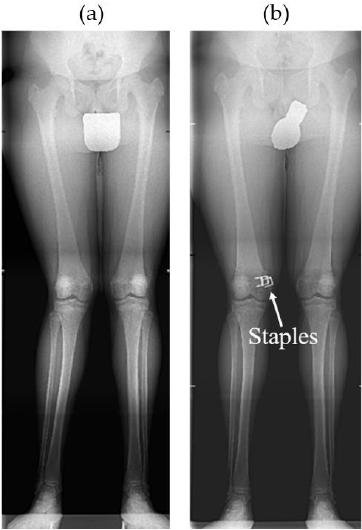
Figure 2. (a) Long radiogram of preoperative genu valgum and ( b ) consecutive correction with sta- ples in femur; see [4].